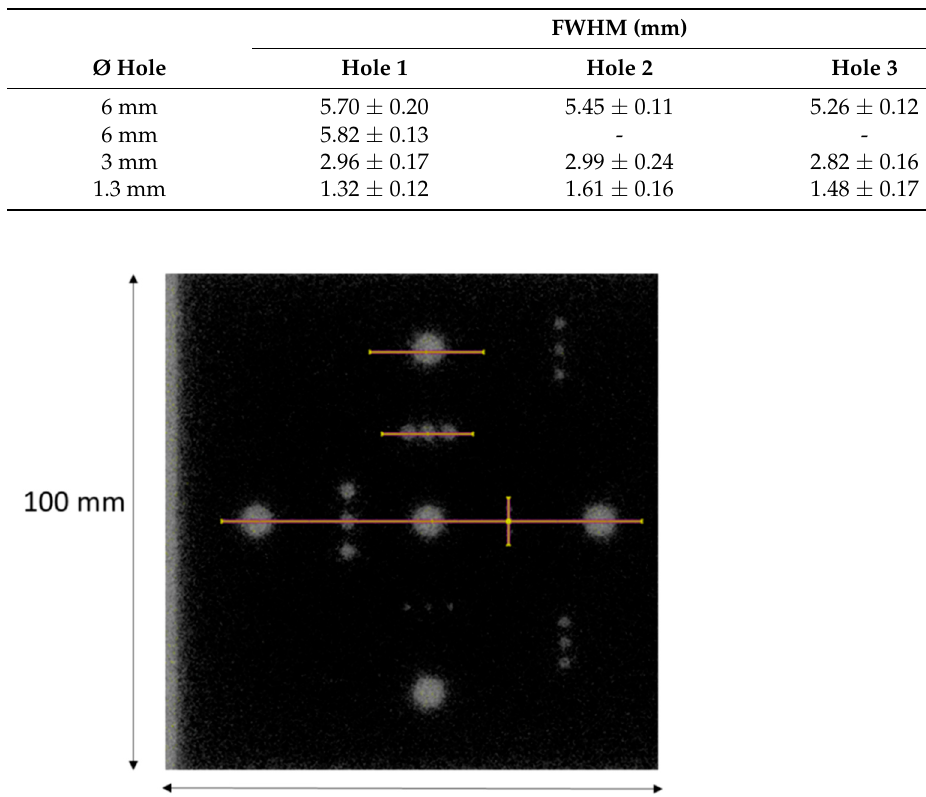
Figure 15. Simulated ESF for the edge projection fitted by a logistic function. The results were ob- tained for a detector-source distance of 230 cm, a beam aperture of 1 cm and 40 kV X-rays. The error bars are smaller than the data points.